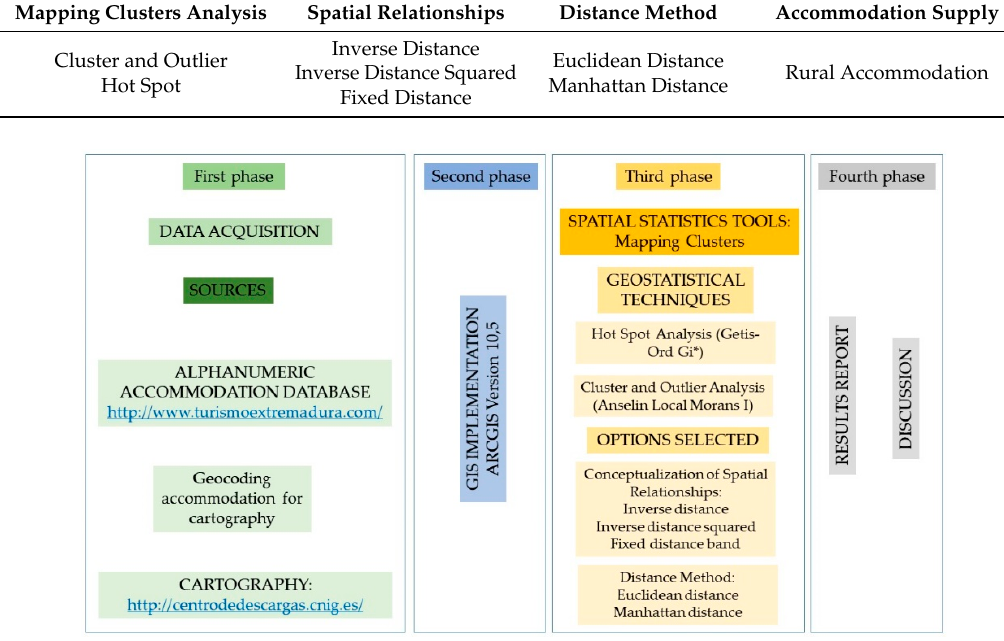
Figure 4. Methodological process.